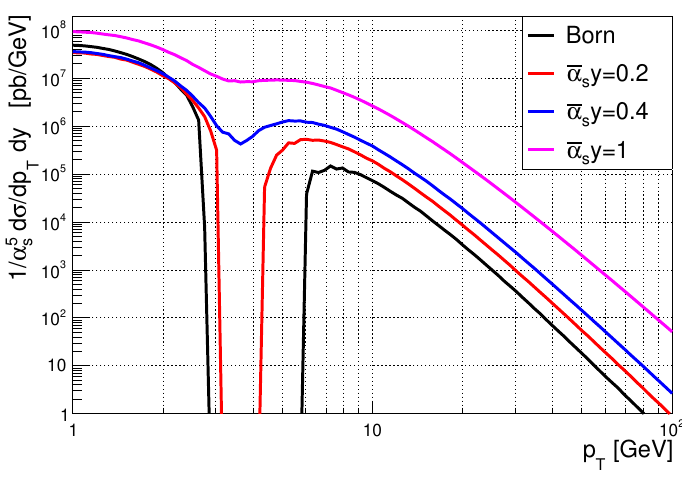
Figure 5 . Partonic cross section with the correlated Pomeron loop, eq. (3.4) as a function of transverse momentum for di(cid:11)erent values of rapidity.